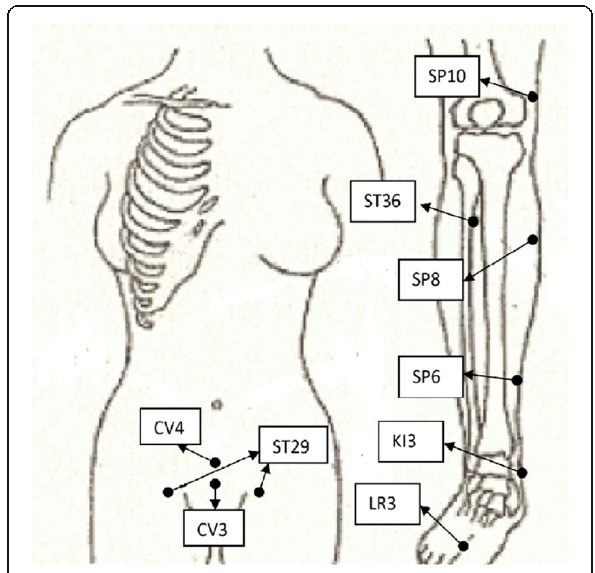
Fig. 1 Main body acupoints used in acupuncture